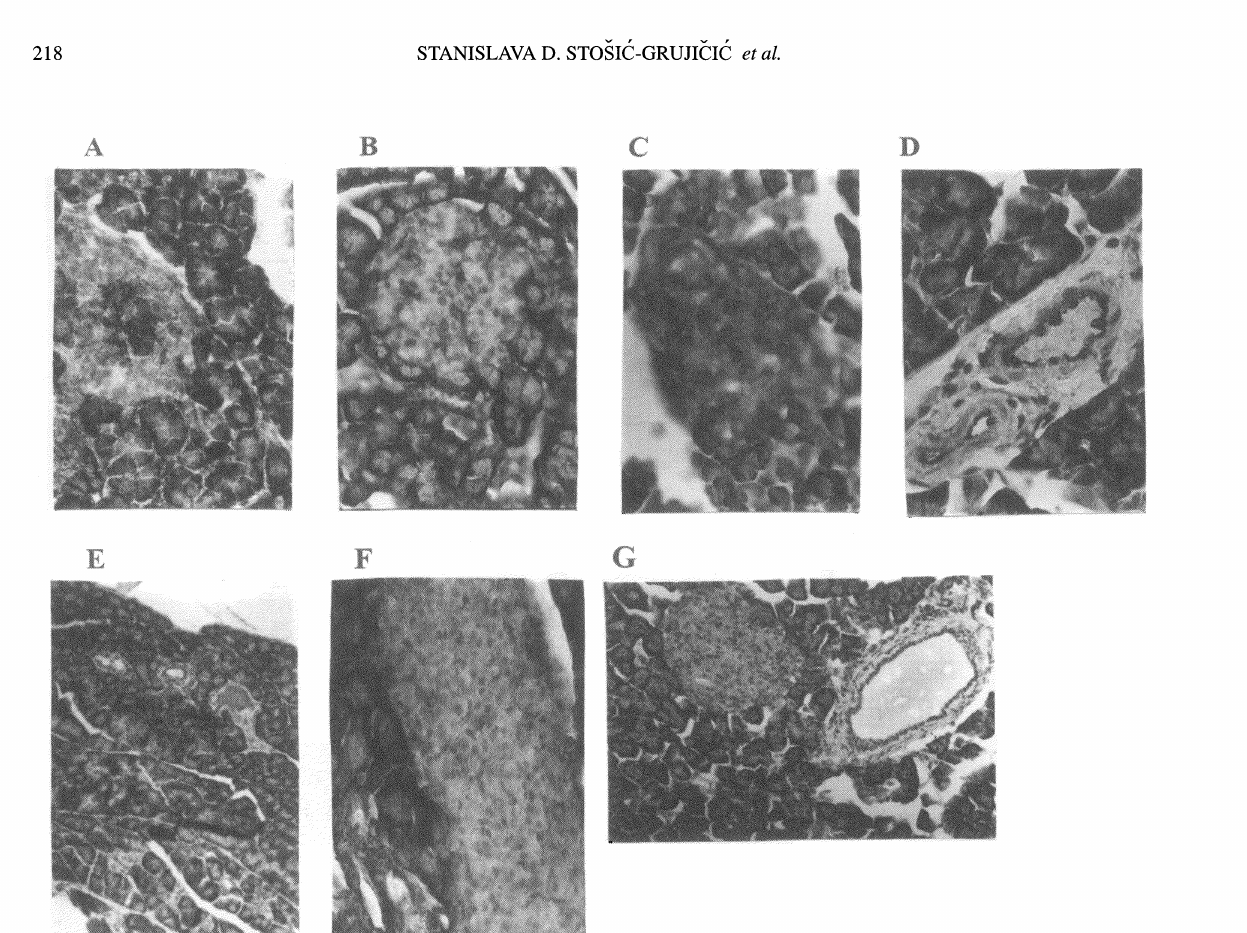
FIGURE 4 Effects of PTX treatment on the MLD-SZ-induced molecular changes in rat pancreas on day 10, as revealed by immunohisto- chemical staining of pancreata. AP staining to insulin, mag. x 120 (A) and mag. x 60 (E); IFN-7 cells (DB1 mAb, PAP), mag. x 120 (B) and mag. x 120 (F); iNOS cells (NO16 mAb, PAP), mag. x 120 (C), mag. x 180 (D) and mag. x 60 (G); Upper panels, Control DA rats treated with MLD-SZ only. Note paucity of insulin-containing cells restricted to the central area ofthe islet, diffuse pattern of IFN-7 containing cells, and homogenous pattern of iNOS-containing islet cells and endothelial cell layer. Lower panels, DA rats treated with MLD-SZ + PTX. Note homogenous pattern of insulin-containing cells throughout the entire islet, and the absence of IFN-containing and iNOS-containing